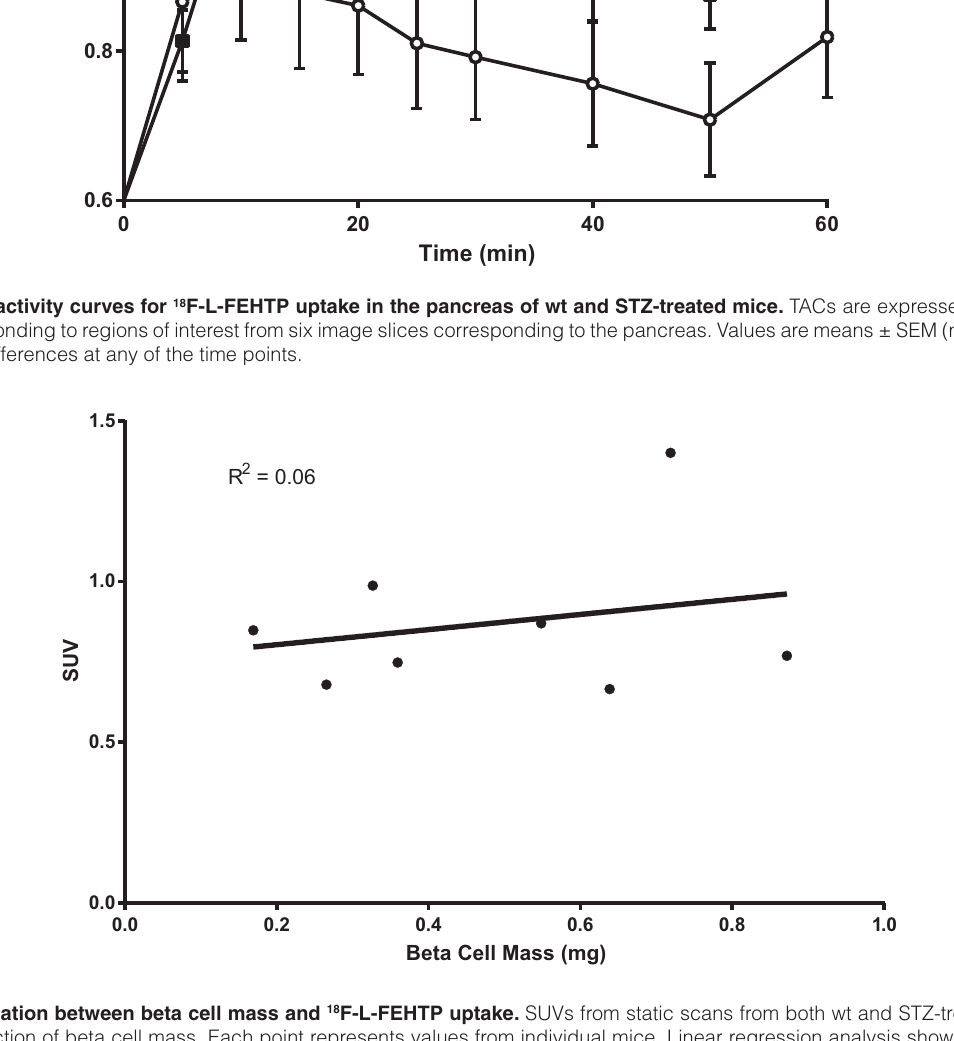
Figure 6. Correlation between beta cell mass and 18 F-L-FEHTP uptake. SUVs from static scans from both wt and STZ-treated mice were plotted as a function of beta cell mass. Each point represents values from individual mice. Linear regression analysis showed no significant correlation between SUV and beta cell